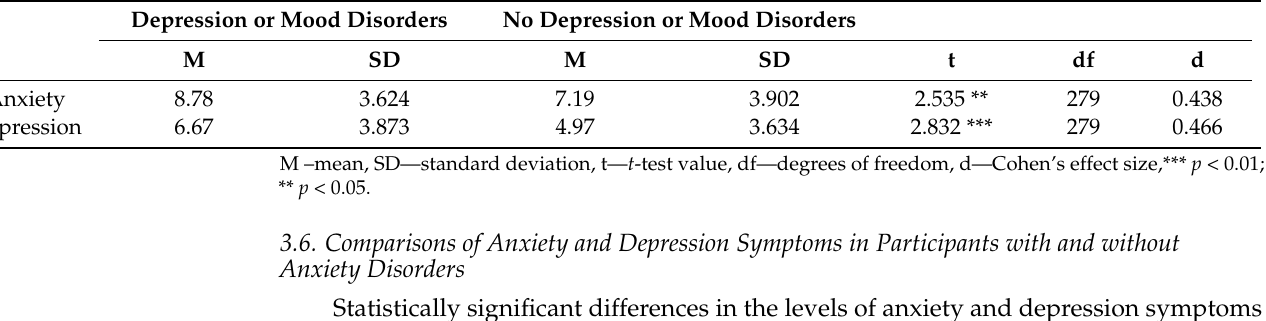
Table 5. Comparisons of HADS scores for participants with and without depression or mood disorders.